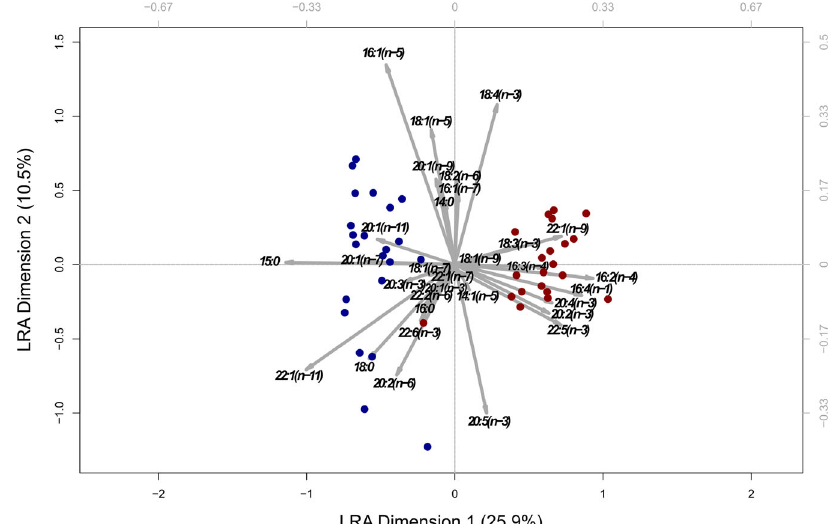
Fig. 6 Results of the unweighted log-ratio analysis (LRA) of fatty acids pro fi les. Fatty acids were extracted from the tissue of krill and salps ( n = 21 and 22, respectively). The results of this analysis were plotted using a contribution biplot with a rescaling factor of three to allow for a better interpretation of dispersion. Krill samples are depicted in red and salp samples are shown in blue. Arrows depict the single fatty acids, while the length of the arrows corresponds to the relative contribution of the respective fatty acid to the explained variance. The explained variance for the fi rst two dimensions is given in